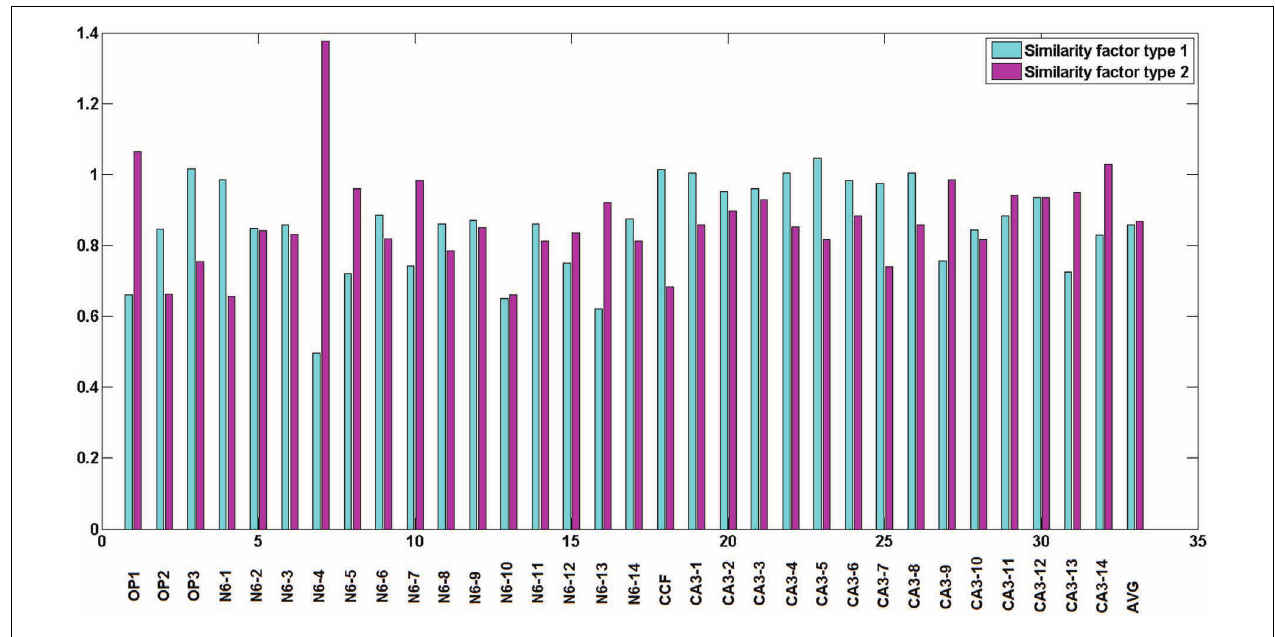
The results are averaged over the topologies obtained with noise levels: 0, 0.01, 0.03, 0.05, 0.07, 0.09, 0.1, and 0.15. Last two bars show average similarity factors over all